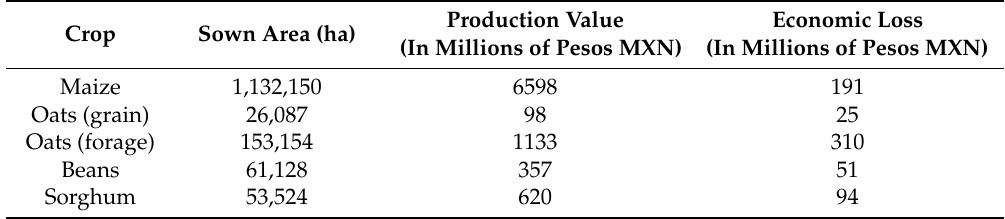
Table 4. Planted area, production value, and economic loss estimated for four crops of economic importance in the city belt of Central